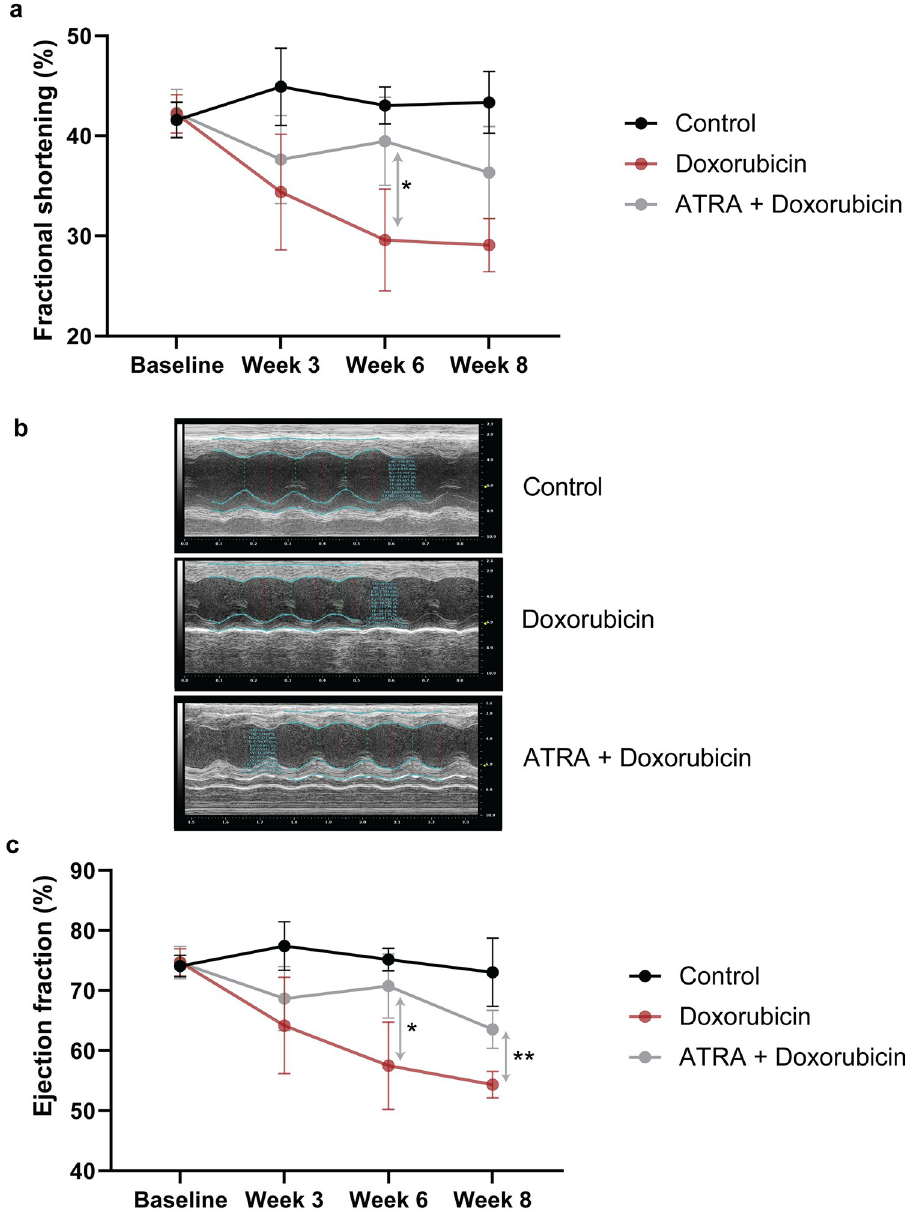
Fig 4. ATRA is cardioprotective in doxorubicin-treated mice as demonstrated by echocardiography. (a) Fractional shortening measurements to evaluate cardiac systolic function in control (saline-treated), doxorubicin-only treated, and ATRA + doxorubicin-treated mice. The graph shows percent fractional shortening, at baseline, after three, six, and eight weeks of weekly doxorubicin/saline treatments (N = 5 mice per group). Data are presented as mean ± standard deviation. Statistical analysis was performed using repeated measures two-way ANOVA with Bonferroni multiple comparisons adjustment ( � denotes P = 0.0348). (b) Representative M-Mode echocardiograms in control (saline- treated), doxorubicin-treated, and ATRA + doxorubicin-treated mice after eight weeks of study (cumulative doxorubicin dose of 24 mg/kg in the doxorubicin-treated mice). The y-axis denotes the distance (in mm) from the transducer, and the x-axis denotes time (in ms) [38, 39]. The blue line outlines the left ventricular anterior and posterior walls. The green dotted line represents chamber width during systole, and the red dotted line denotes the chamber width during diastole. (c) Ejection fraction measurements to evaluate cardiac systolic function in control (saline-treated), doxorubicin-only treated, and ATRA + doxorubicin-treated mice. The graph shows percent ejection fraction at baseline, after three, six, and eight weeks of weekly doxorubicin/saline treatments (N = 5 mice per group). Data are presented as mean ± standard deviation. Statistical analysis was performed using repeated measures two-way ANOVA with Bonferroni multiple comparisons adjustment ( � , and �� denote P = 0.0193 and P = 0.0020,